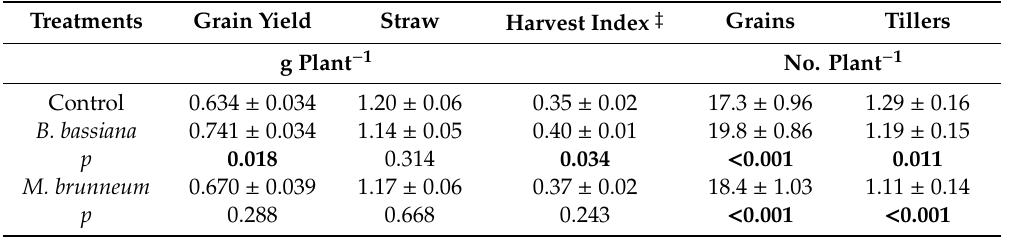
Table 2. Paired t -test for biomass variables (mean ± SE, n = 72) of inoculated versus non-inoculated plants at harvest (102 DAS). Significant p -values ( p < 0.05) are in